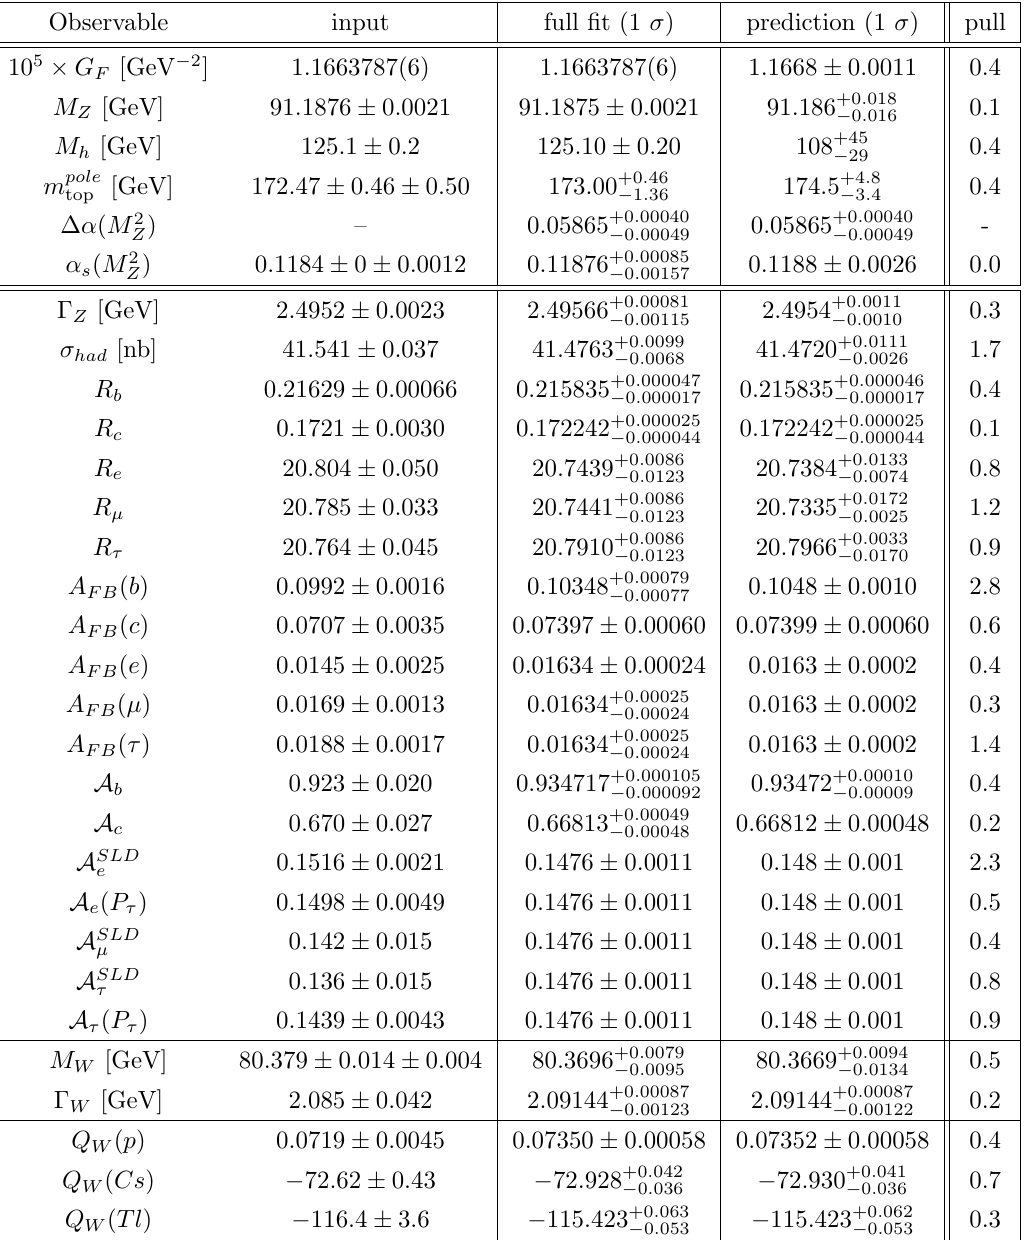
Table 1 . Results of the global (cid:12)t in the SM. The (cid:12)rst row gives the parameters of the (cid:12)t, f G F ; M Z ; M H ; m pole ; (cid:1) (cid:11); (cid:11) s ( M 2 ) g . The third column, \full (cid:12)t", gives the result from the (cid:12)t, the top Z fourth one, \prediction", is the value of the observable predicted in the SM without knowledge of its experimental value, while in the last column the pull is de(cid:12)ned as in eq. (6.3) . The inputs are taken from: [42] for G F and (cid:11) s , [80] for m pole , [93] for M h , [71] for M Z and the EWPO in the second top row, [80, 94{96] for M W , [97] for (cid:0) W , [98] for Q W ( p ), [42, 99, 100] for Q W ( Cs ) and [101, 102] for Q W ( Tl ). When two uncertainties are present, the (cid:12)rst is statistical while the second is theoretical, treated in the R(cid:12)t scheme of [36, 38,